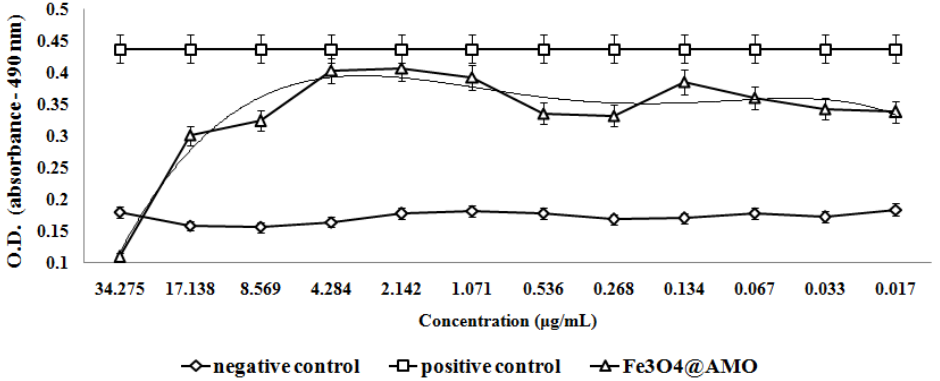
Figure 11. The effect of Fe of